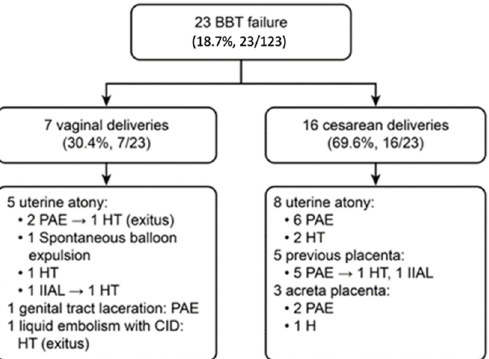
Figure 1. Flowchart of studies retrieved and included in the systematic review. Abbreviation: BBT: Bakri Balloon Tamponade. PAE: Pelvic Arterial Embolization. HT: Hysterectomy. IIAL: Internal Iliac Arterial Ligation. DIC: disseminated intravascular coagulation.